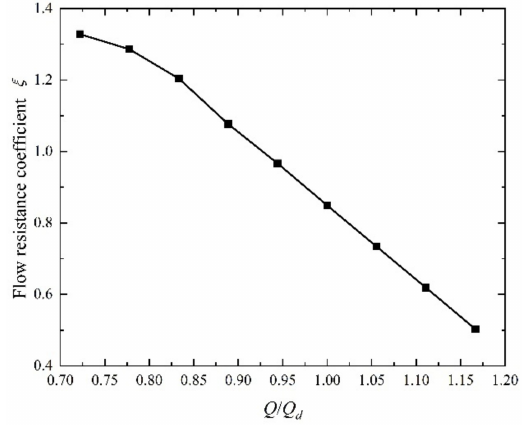
Figure 13. The clearance flow resistance coefficient.